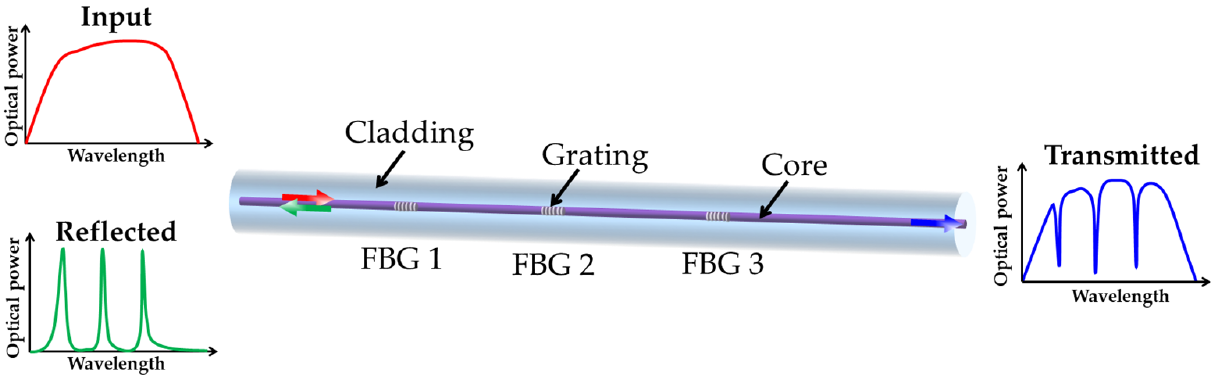
Figure 6. Operating principle of quasi ‐ distributed FBG sensor.